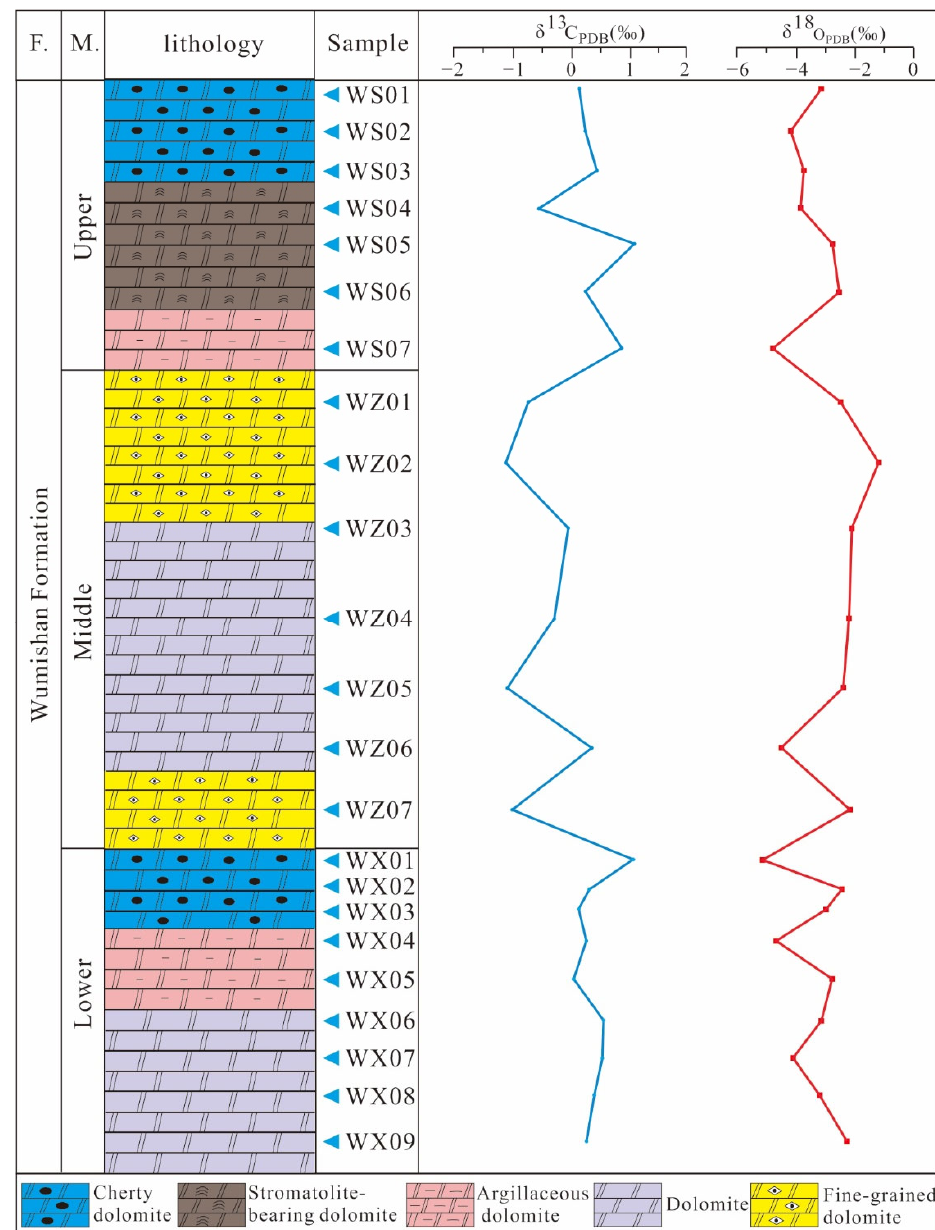
Figure 9. Vertical δ 13 C and δ 18 O profiles of the carbonate rocks from the Gaoyuzhuang Formation.